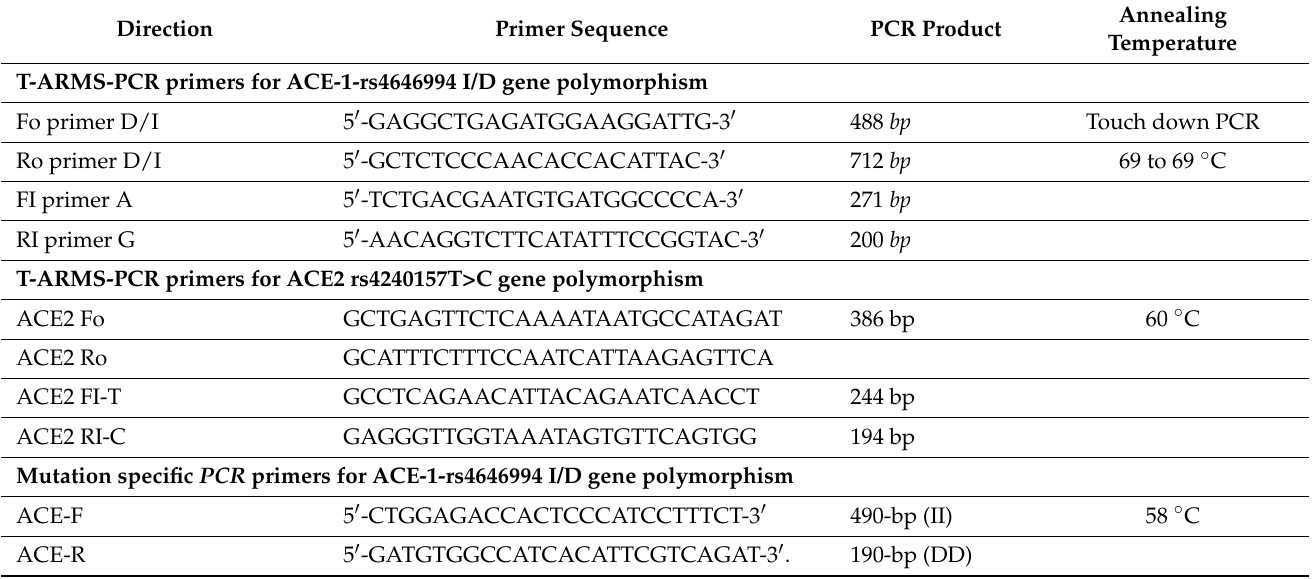
Table 1. Primer sequences for ACE2 gene